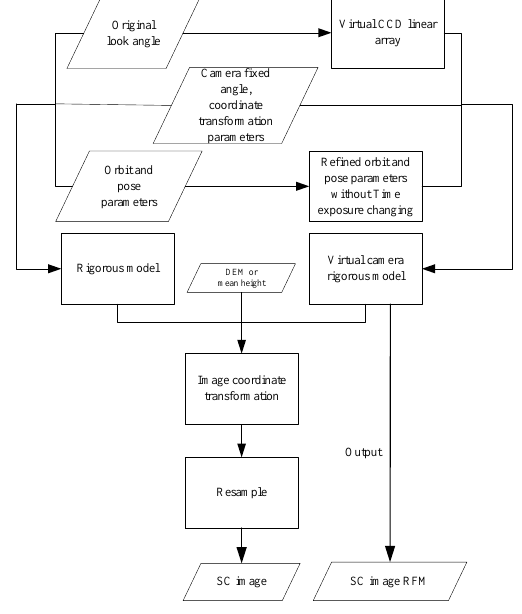
Figure 3. Process flow of SC